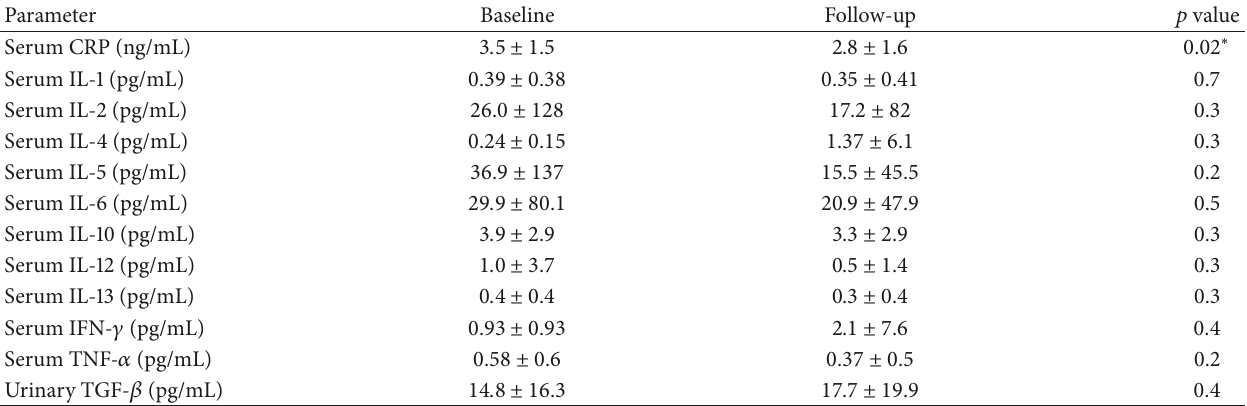
Table 3: Effect of Gum Arabic dietary supplementation on mean values of various inflammatory markers in studied chronic kidney disease patients ( 𝑛 = 30